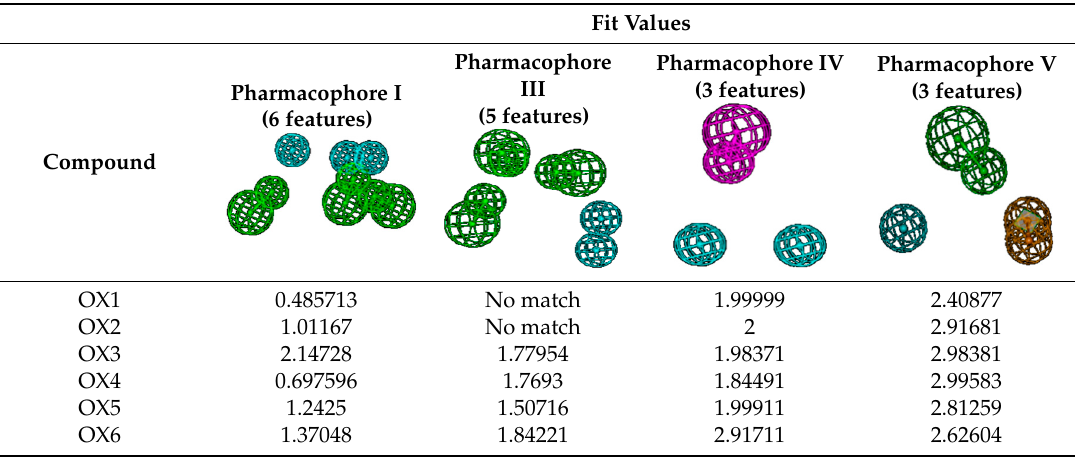
Figure 10. ( A ) Xanthone OX3 fit to pharmacophore I (P-gp induction); ( B ) Xanthone OX6 fit to pharmacophore IV (P-gp induction); ( C ) Xanthone OX4 fit to pharmacophore V (P-gp activation). Green spheres = hydrogen acceptor; pink spheres = hydrogen-donor; blue sphere = hydrophobic; yellow spheres = aromatic. Table 4. Fit values of the six tested oxygenated xanthones OX 1–6 to P-glycoprotein (P-gp) induction